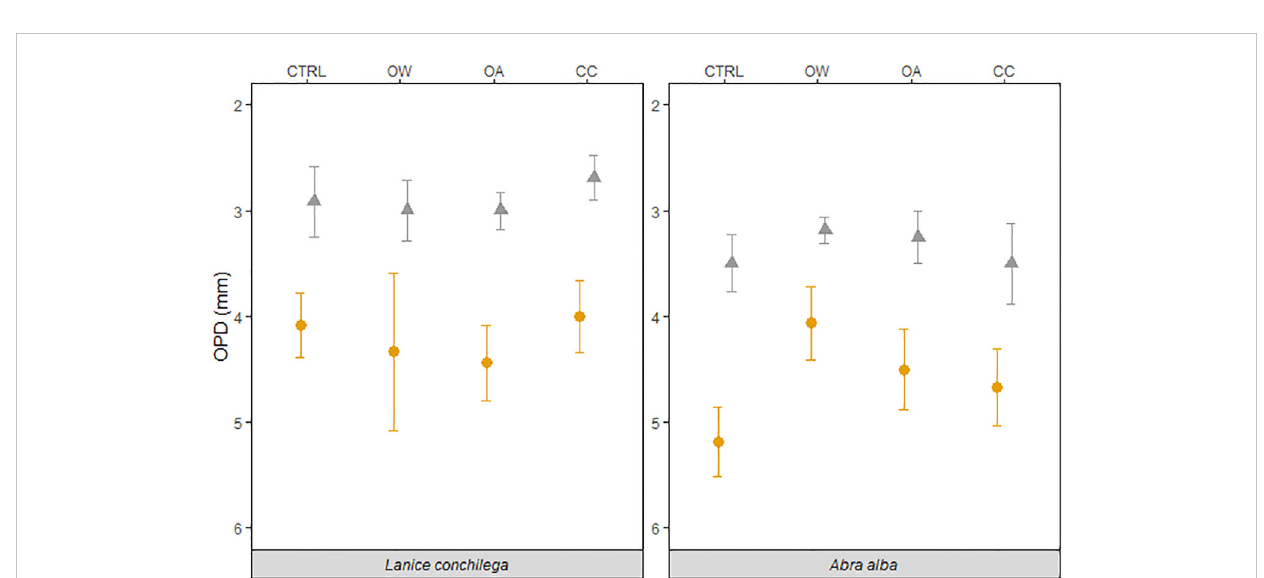
FIGURE 2 Temperature and pH effect on the oxygen penetration depth in the presence (orange circles) and absence (grey triangles) of L. conchilega and A. alba . Error bars represent the standard errors (± SE, n = 4).